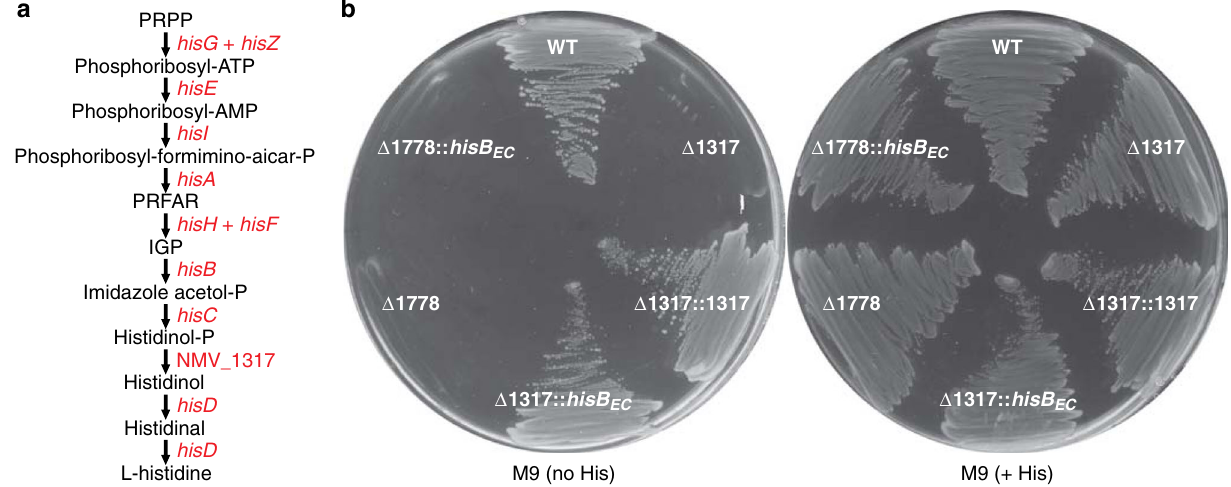
Fig. 6 NMV_1317 encodes a novel histidinol-phosphatase. a Histidine biosynthesis pathway in the meningococcus, with genes highlighted in red. PRPP 5- phosphoribosyl diphosphate, PRFAR phosphoribulosylformimino-AICAR-P, IGP erythro-imidazole-glycerol-P. b Growth on M9 minimal medium, with or without added histidine (His). The plates also contained 0.5 mM IPTG for inducing expression of the complementing genes. WT, strain 8013; Δ 1317, Δ NMV_1317 mutant; Δ 1317::1317, Δ NMV_1317 complemented with NMV_1317; Δ 1317:: hisB Δ NMV_1317 cross-complemented with hisB EC , EC from E. coli , which encodes the unrelated histidinol-phosphatase present in this species; Δ 1718, Δ NMV_1718 mutant; Δ 1718:: hisB EC , control showing that Δ NMV_1718 ( hisH ) cannot be cross-complemented by hisB EC . Source data are provided as a Source Data fi